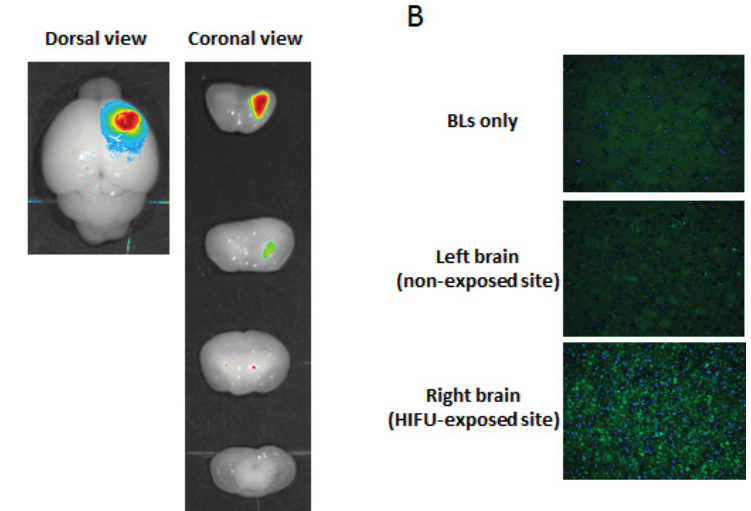
Figure 6. Delivery of fluorescent-labeled PMOs into the brain by the combination of BLs and HIFU exposure. ( A ) Ex vivo brain imaging of fluorescent-labeled PMO. Fluorescent-labeled PMO and BLs were intravenously injected into the mice, and then the right hemispheres were exposed to 3.5 MHz pulsed HIFU conditions